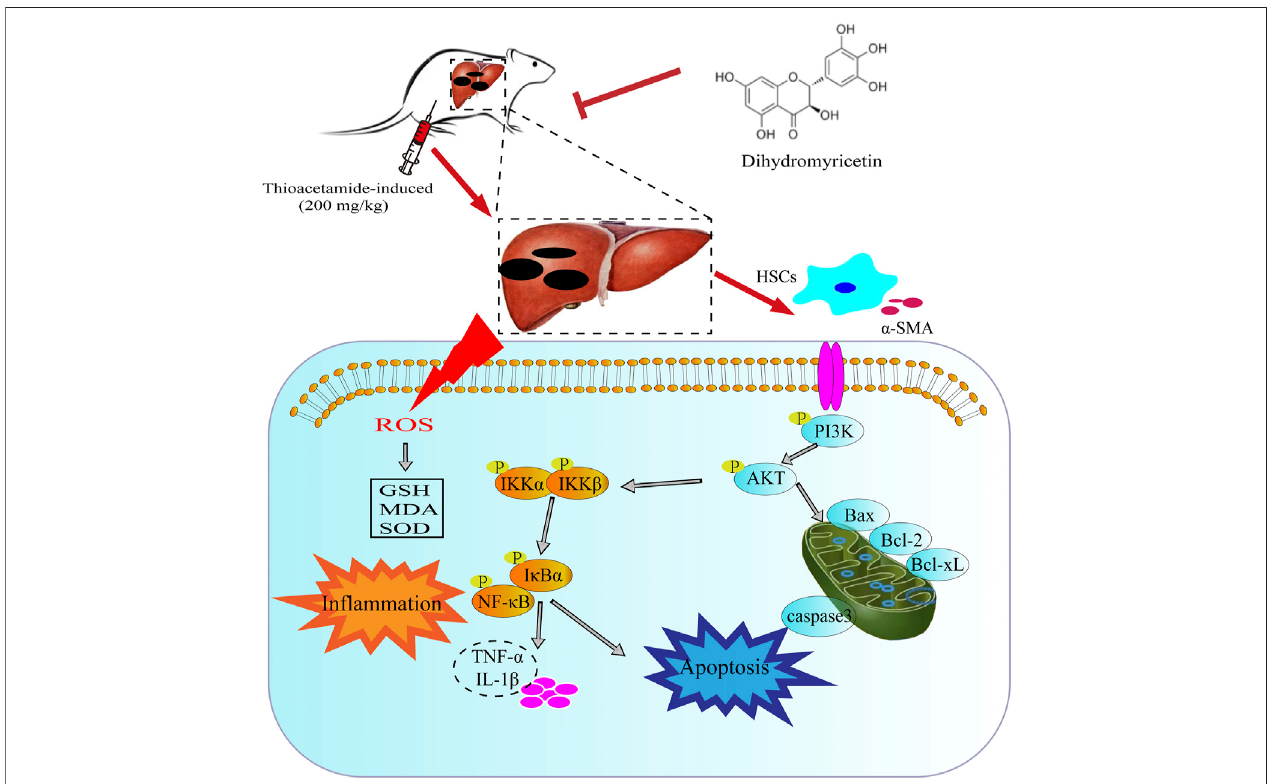
FIGURE 7 | The potential mechanism of DHM in alleviating TAA-induced liver fi brosis. DHM reverses TAA-induced liver fi brosis by inhibiting suppression of HSC activation, NF- κ B-mediated in fl ammatory in fi ltration and improving PI3K/Akt-mediated apoptosis, which may be a potential mechanism for the hepatoprotective effects of